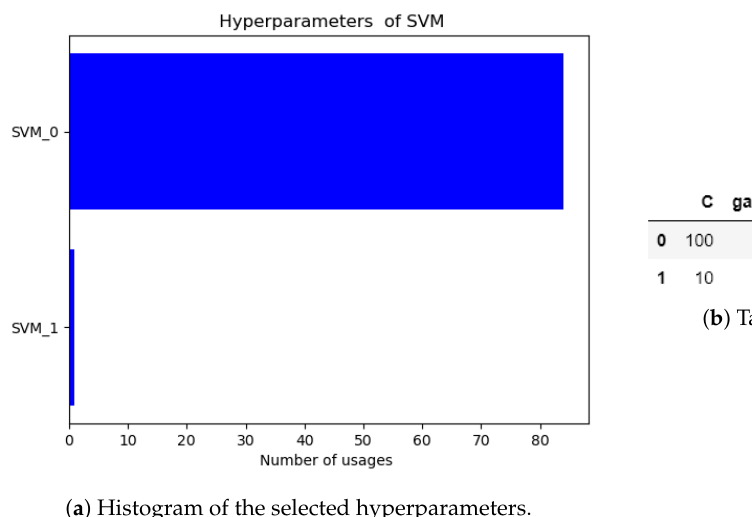
Figure 13. Histogram of the selected hyperparameters of the nonlinear oscillator.